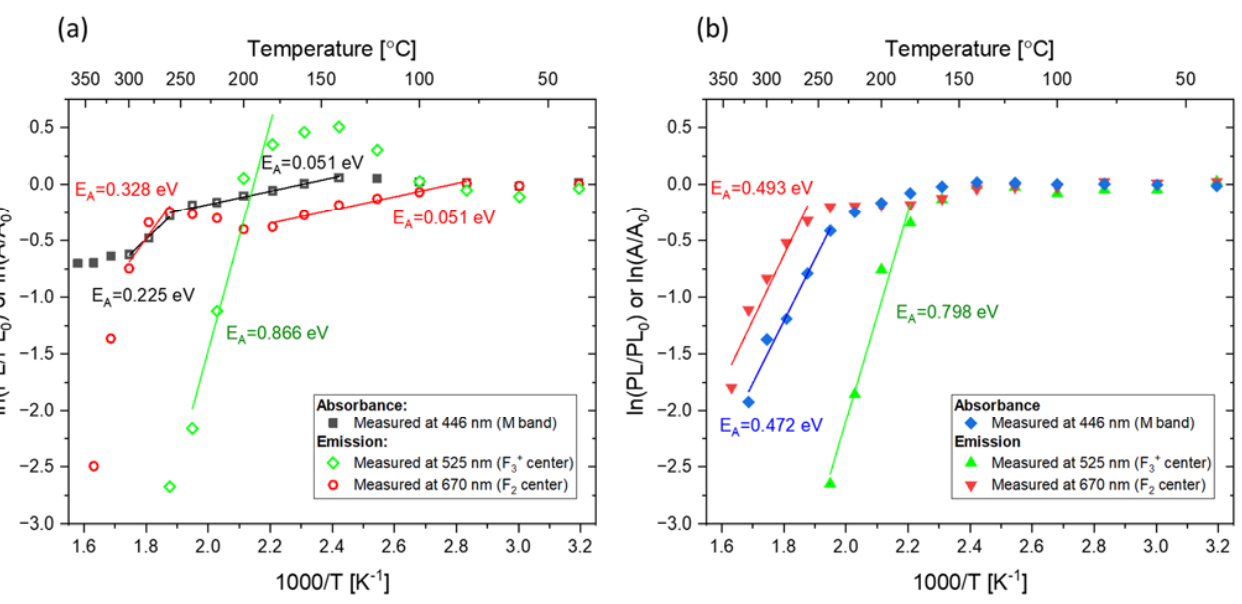
Figure 8. Comparison of the changes in absorption and PL intensity with respect to the values at room temperature measured for: ( a ) sample irradiated with beta radiation (30 kGy) and ( b ) sample irradiated with alpha particles (fluence 3.4 × 10 12 cm − 2 ) and subjected to Method 1.